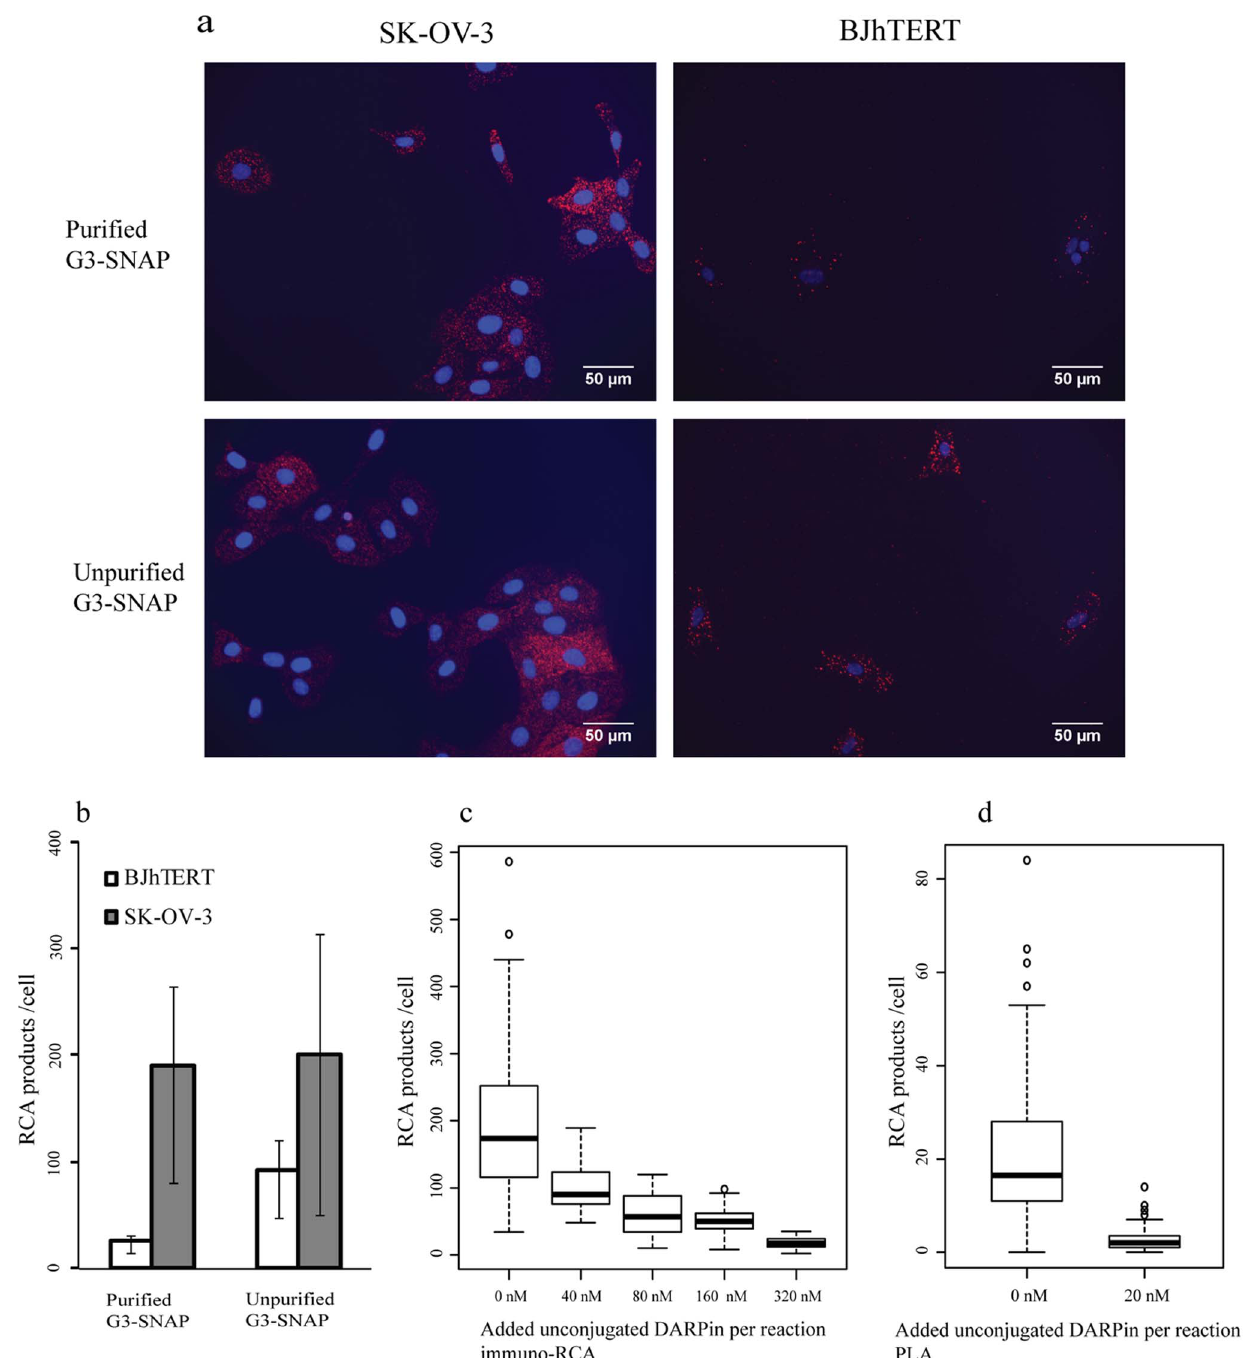
Figure 4. Detection of HER2 proteins using immuno-RCA and insitu PLA in fixed cells. (a) 5 nM pure G3-SNAP conjugates and 5 nM unpurified G3-SNAP conjugates were separately used in immune-RCA to detect HER2 proteins in HER2-positive (SK-OV-3) or -negative (BJhTERT) cells. Red dots represent RCA products arising from immuno-RCA reactions detected with fluorescence labeled complementary oligonucleotides. The numbers of RCA products per cell from those images are shown in bar charts (b). (c) Boxplots present the numbers of RCA products per cell when mixes of pure G3-SNAP conjugates (5 nM) and different amounts of unconjugated G3-SNAP (from 0 nM to 320 nM) were used to detect HER2 proteins via immuno-RCA in SK-OV-3 cells. (d) Boxplots reflect the number of RCA products per cell after in situ PLA for detection of HER2 protein in SK-OV-3 cells, probed with pure probe conjugates (20 nM G3-SNAP conjugates and 20 nM 9.01-SNAP conjugates), mixed with different amounts of unconjugated DARPin binders (G3-SNAP and 9.03-SNAP at concentrations of 0 nM or 20 nM). The cell nuclei were counterstained with DAPI (blue).